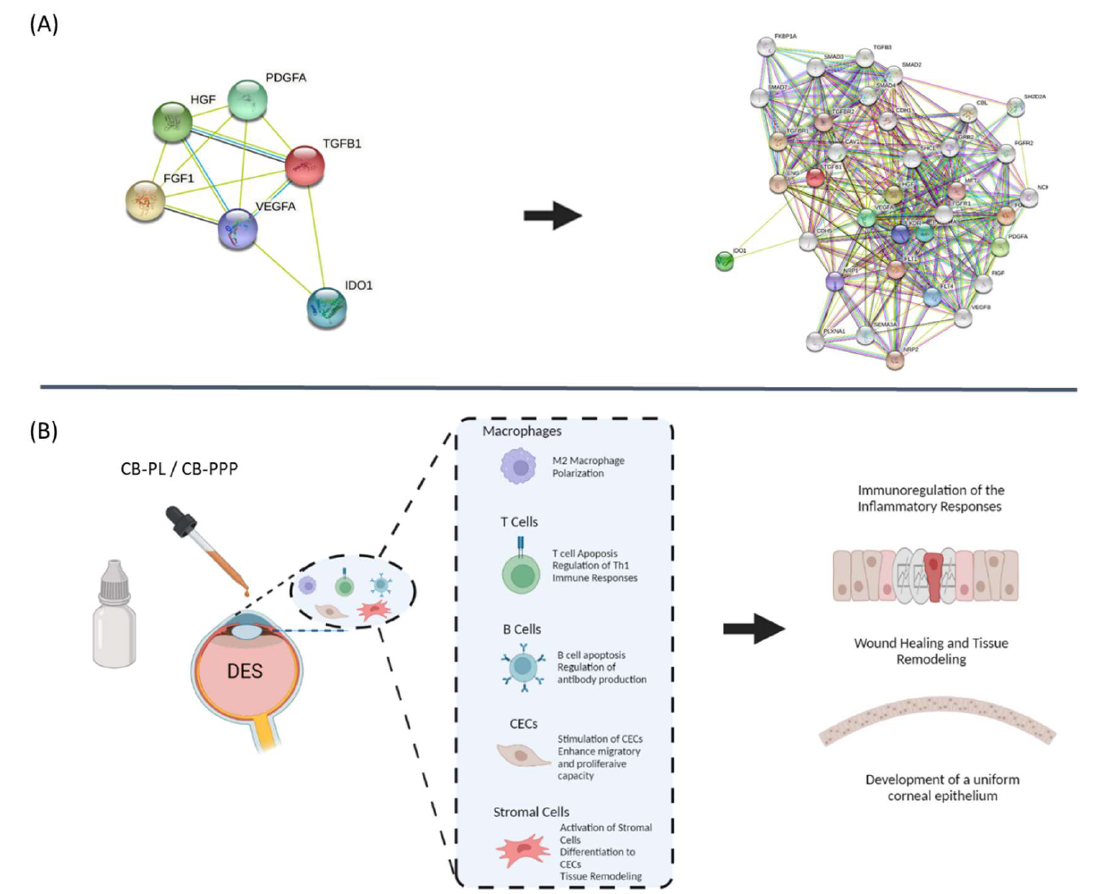
Figure 6. Tissue remodeling model of damaged corneal surface due to DES. ( A ) Functional protein analysis of CB-PL and CB-PPP using the online tool STRING (https://string-db.org, 15 June 2022). ( B ) Proposed model relied on the functional analysis data. DES is characterized an inflammatory process which can further lead to corneal surface damage. After the application of CB-PL/CB-PPP, the secreted proteins can ameliorate the activated immune responses through macrophage polarization, T and B cell immunomodulation, and apoptosis. Then, CECs of the wounded region can be re-activated due to growth factor presence, resulting in advanced adhesion, proliferation, and production of tissue remodeling proteins.